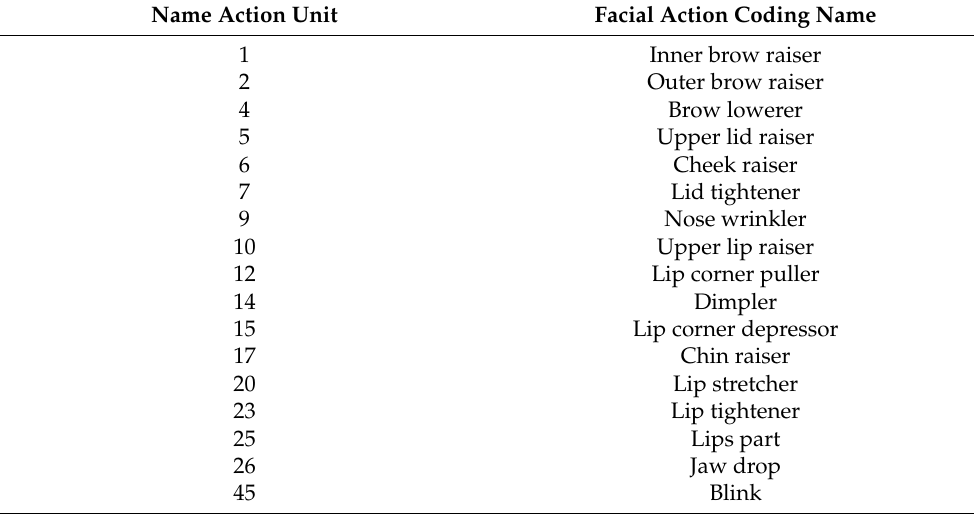
Table 2. AUs extracted with